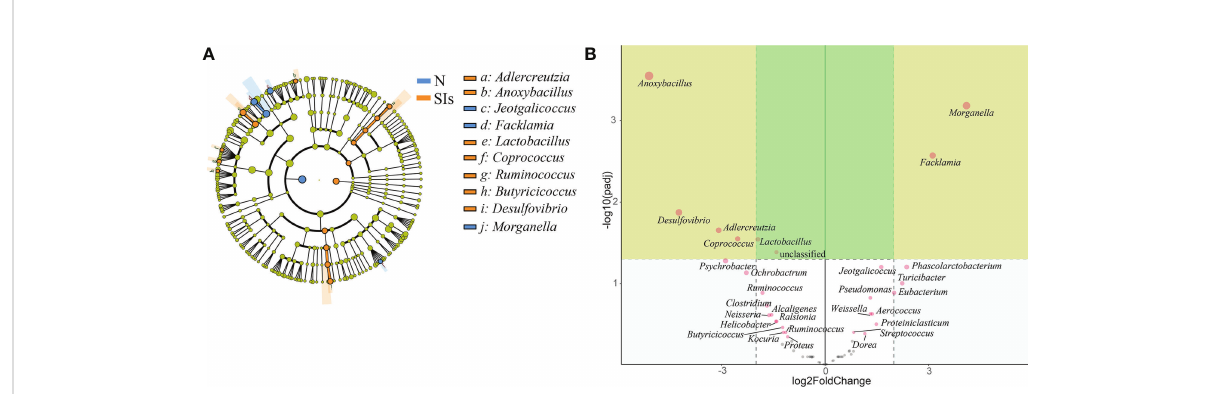
FIGURE 5 Signi fi cance analysis on operational taxonomic unit (OTU) difference of lumen-associated bacteria between groups. (A) Linear discriminant analysis effect size (LEfSe) analysis at the genus level (linear discriminant analysis [LDA] score > 4). (B) DESeq2 analysis at the genus level. N, normal group; SIs, soybean iso fl avones group.